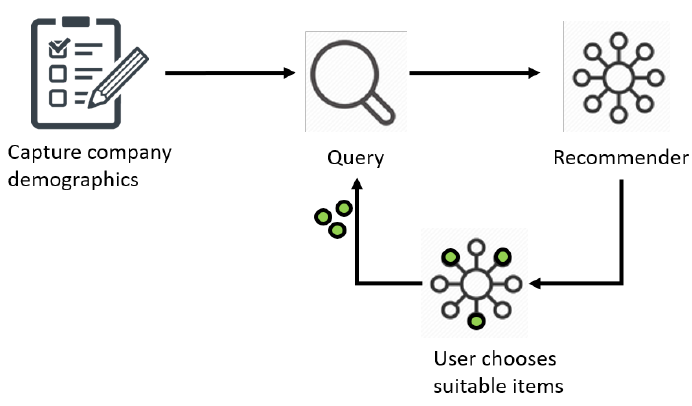
Figure 1. Iterative process for business consultancy